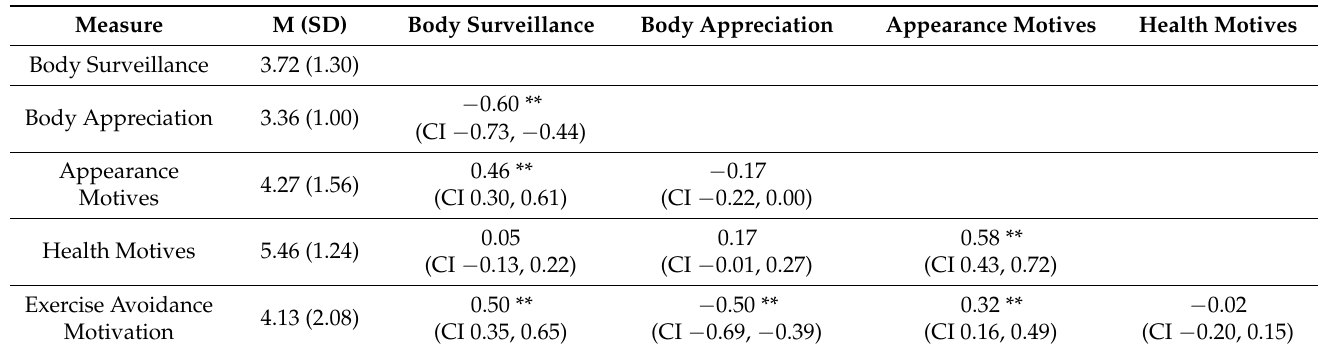
Table 1. Means, standard deviations, and correlations among study variables.